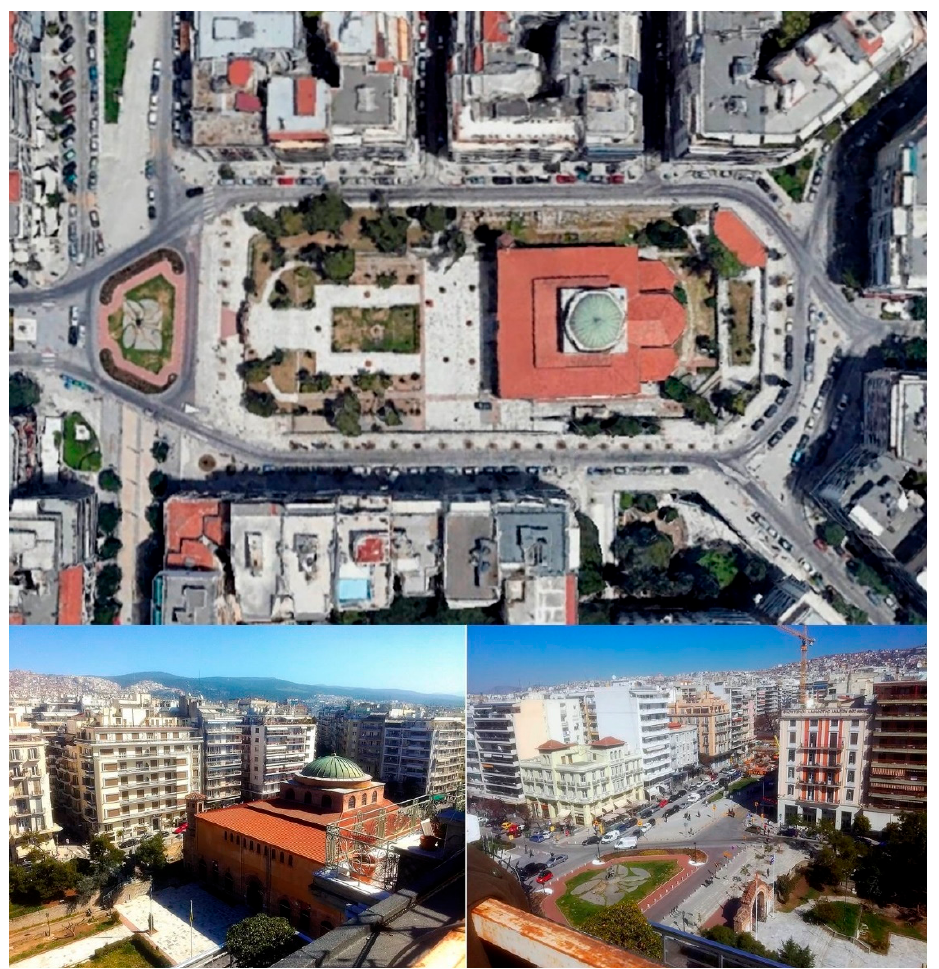
Figure 5. The Hagia Sophia Square presented in the map. The pictures of the area were taken by the authors at the same time as the sampling protocol was followed.